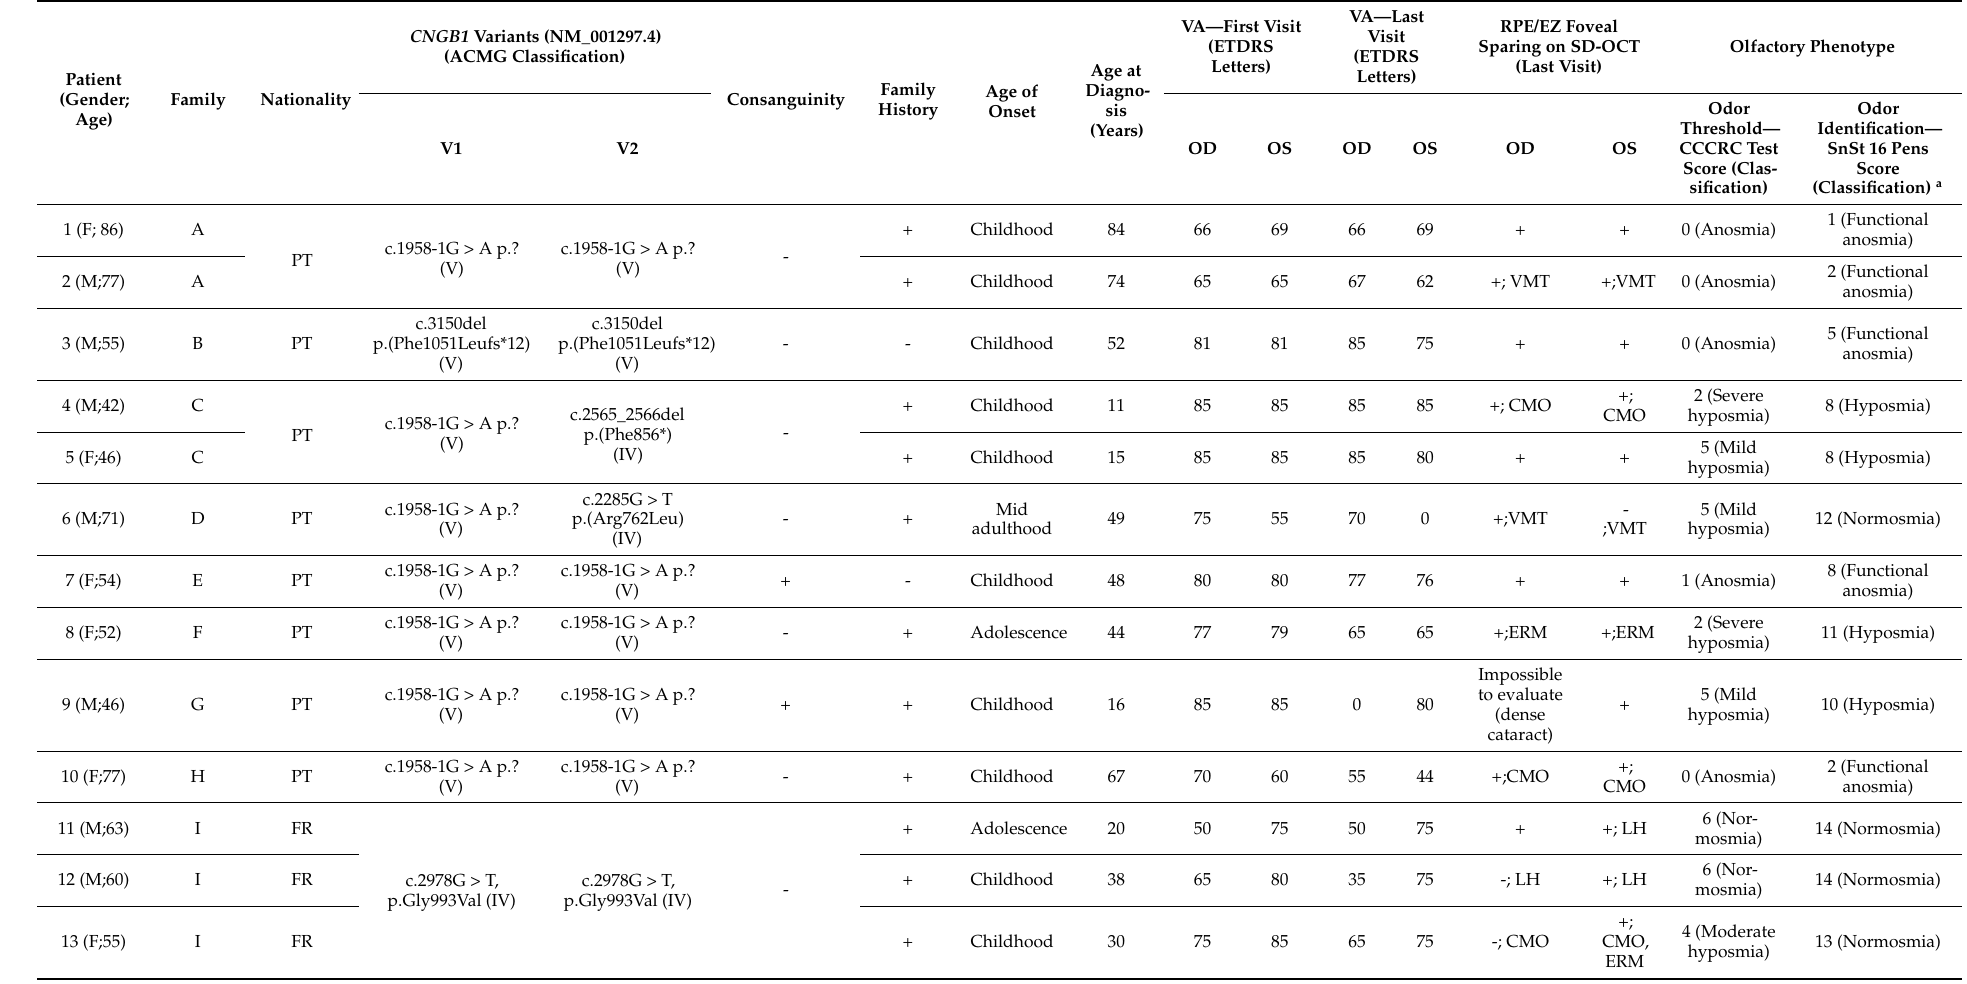
Table 1. Demographic, clinical, and genetic data of the study